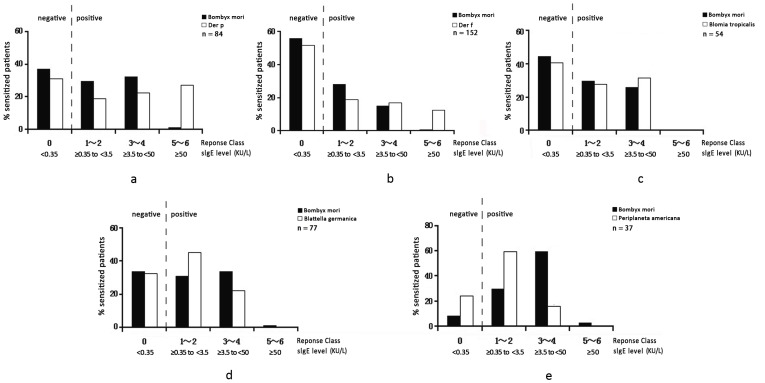
Percentage of patients sensitized to the silkworm moth (Bombyx mori) and 5 common inhalant allergens according to serum concentration of sIgE: Der p (Figure 2a); Der f (Figure 2b); Blomia tropicalis (Figure 2c); Blattella germanica (Figure 2d); Periplaneta americana (Figure 2e).The Y-axis shows the percentage of patients sensitized to allergens. The X-axis shows the concentration range of sIgE (class 1 through 6).